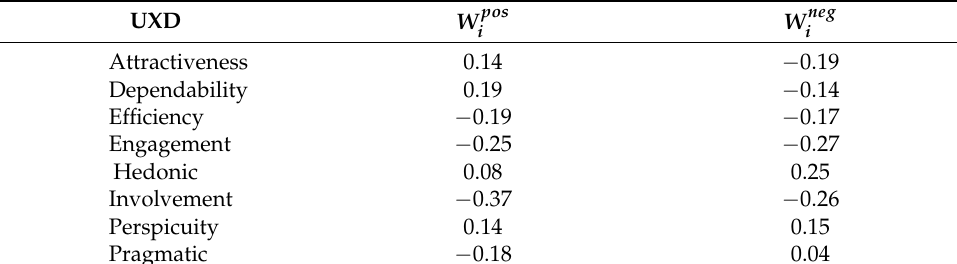
Table 6. The values of positive and nagative vectors generated by ENNM.